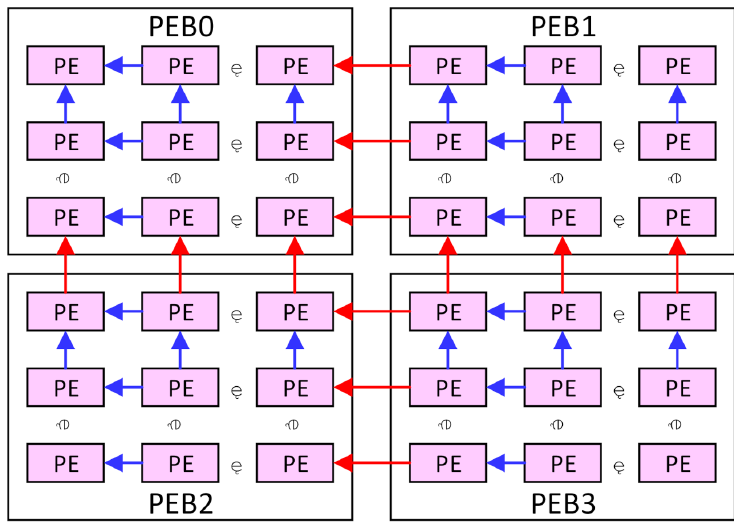
Figure 5. The connection of the